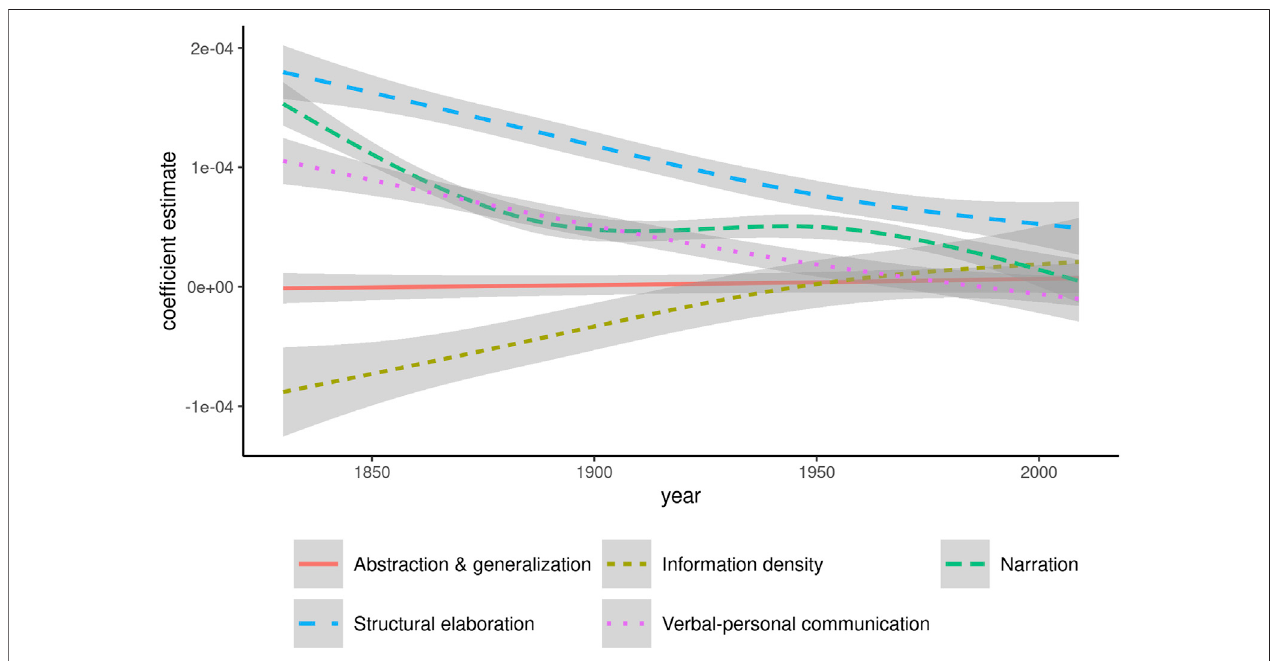
FIGURE 5 | Coef fi cients for individual dimensions in models predicting frequency of whom . Points for individual years were omitted to avoid overplotting.